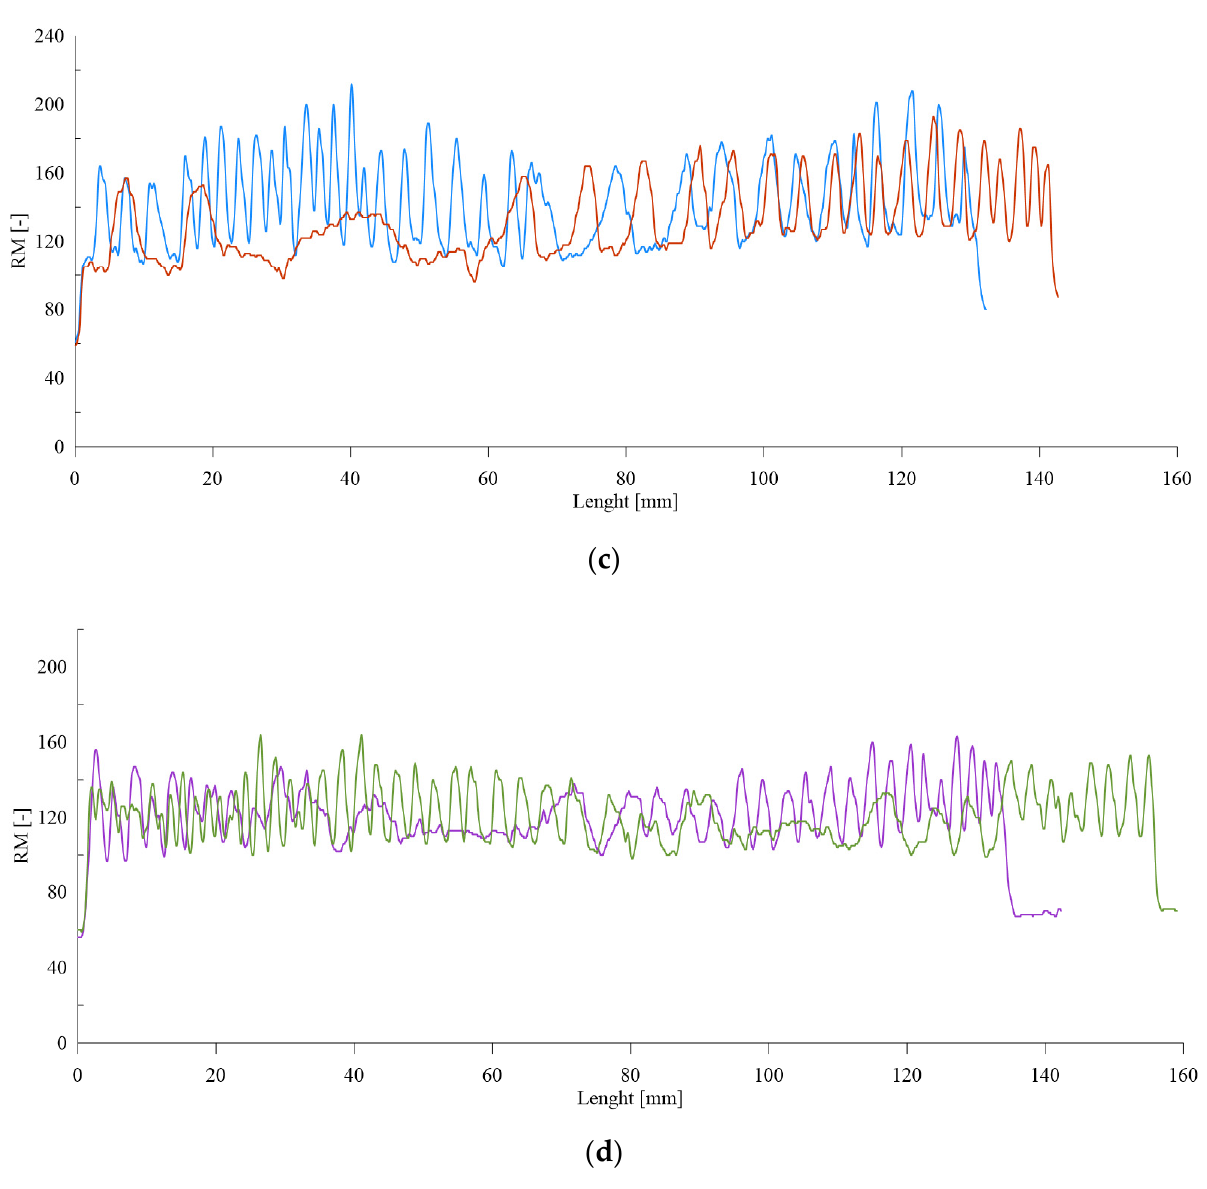
Figure 3. Results of drill resistance tests of samples two and six; ( a ) location of drilling lines in sample two, ( b ) location of drilling lines in sample six, ( c ) drill resistance diagram of sample two, ( d ) drill resistance diagram of sample six.